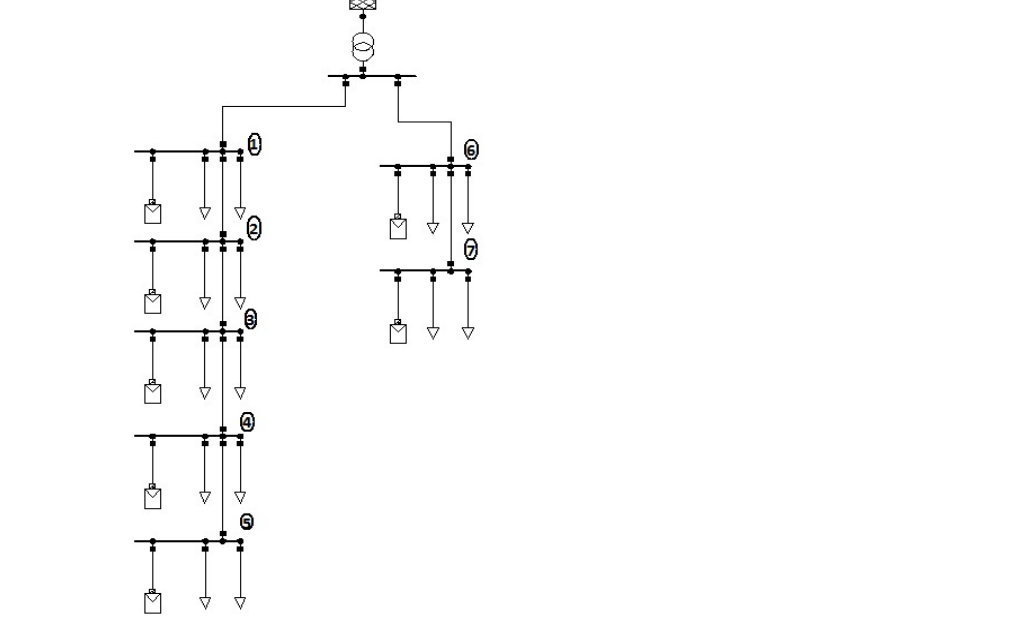
Figure 5. Single-line diagram showing cable layout of network 4 showing the 7 terminals with 14 connected houses as well as the aggregated solar panel installations. connected houses as well as the aggregated solar panel